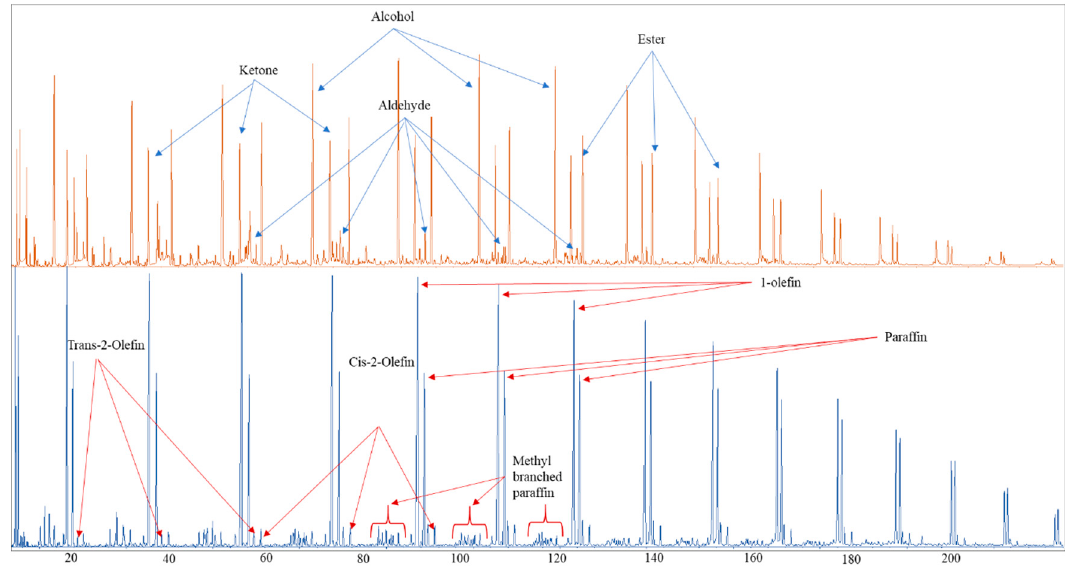
Figure 11. Two separate fractions of oil from a mixture of a multitude of iron FTS runs, separated by silica gel with N 2 , and independently injected upon the MSD. The x-axis is retention time in minutes. The oxygenated chromatogram is only enlarged to display for identification purposes. These were not added to the overall analysis as the mole of carbon % were to small and difficult to quantify.